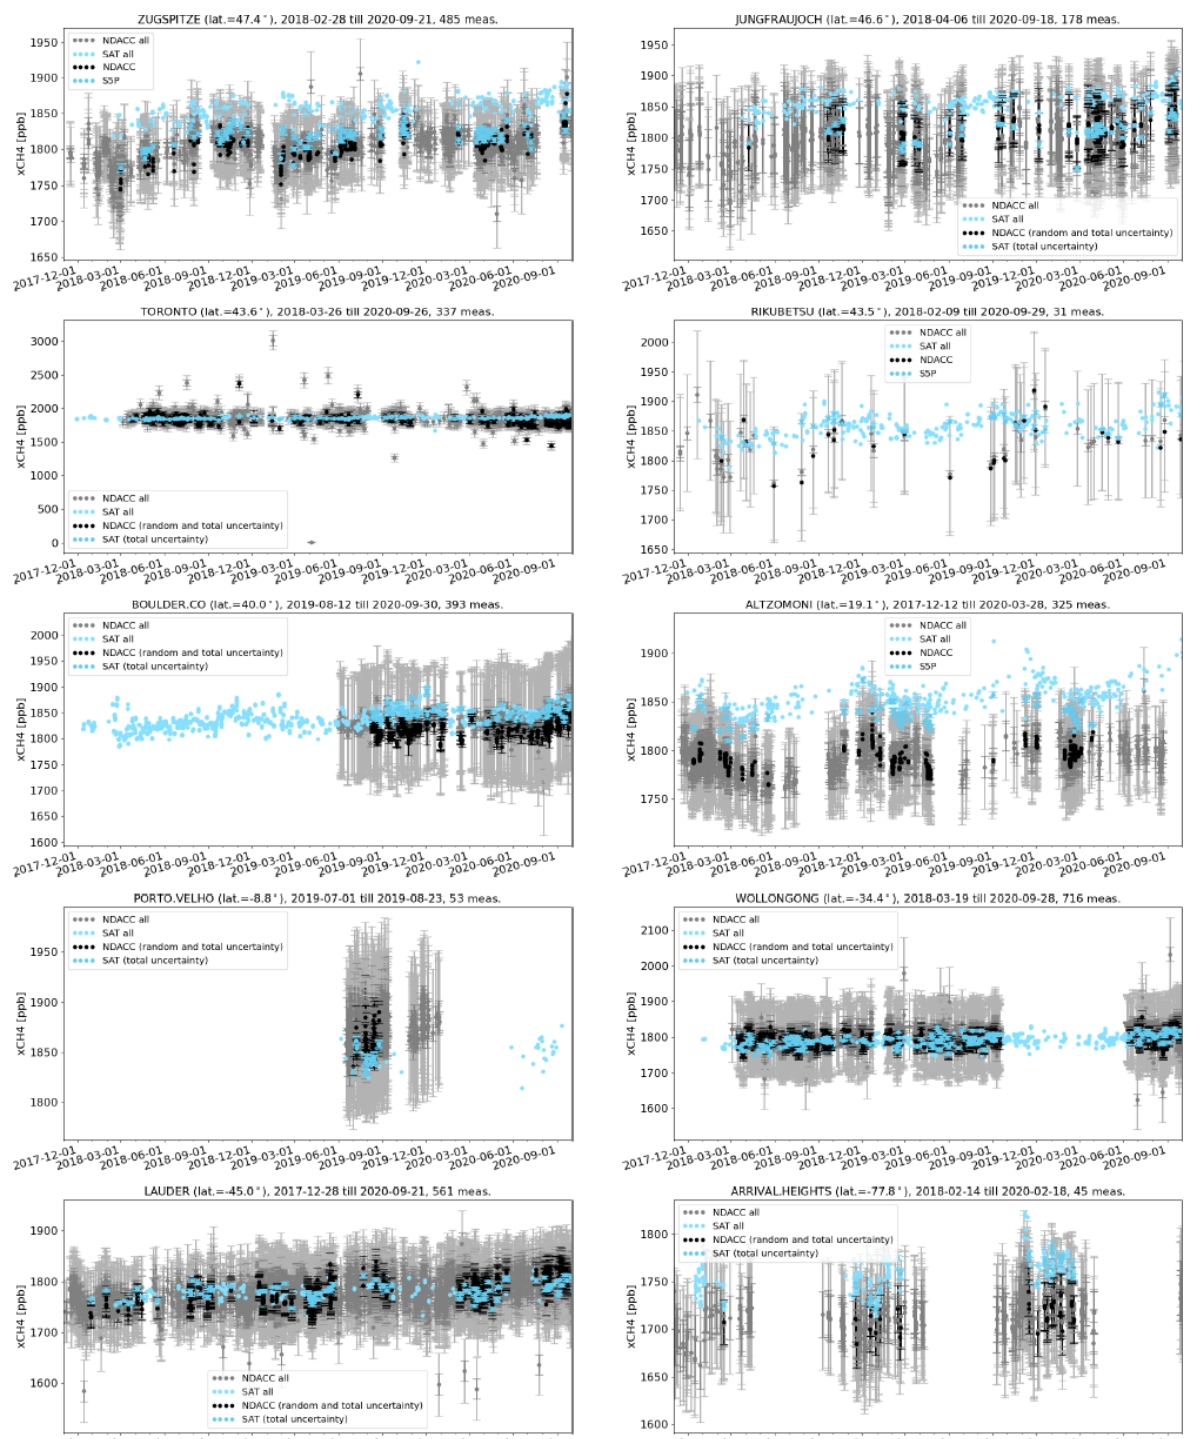
Figure 13. Same as Fig.